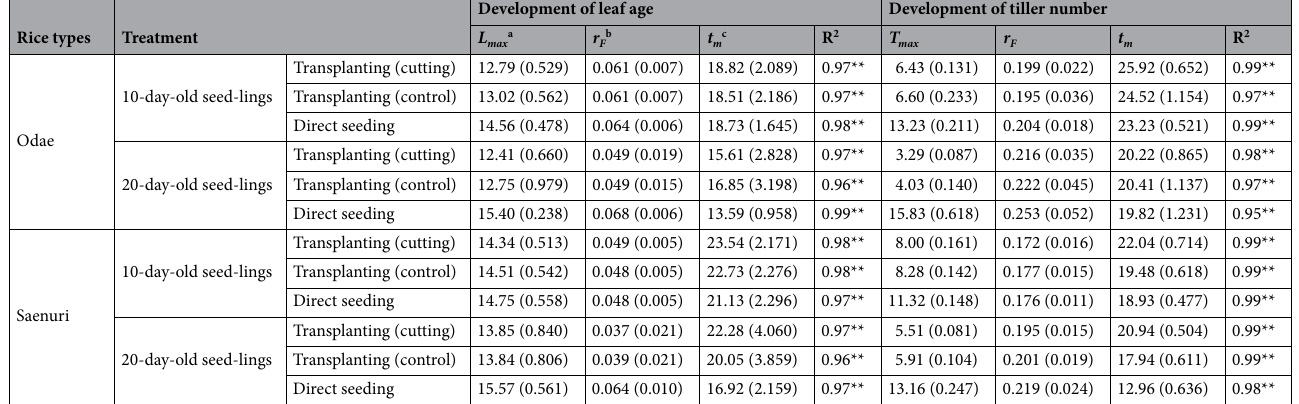
Table 2. Parameters of the logistic function used to describe rice leaf age and tiller development by days after transplanting in relation to root cutting conditions and seedling age. a L max is the final number of leaves, and T max is the final number of tillers. b r F rate of development until the final number of leaves and tillers. c t m t is the number of days after transplanting, tm is the time point at which half the number of final leaves and tillers is reached. ** p <